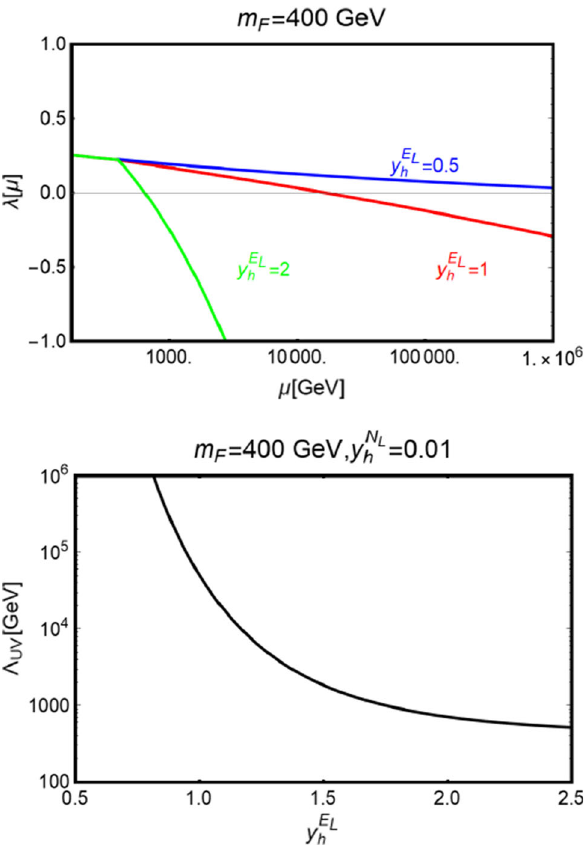
Fig. 3 Top panel evolution of the Higgs quartic coupling λ with the energy scale μ for three assignations, i.e. 0.5, 1 and 2, of the Yukawa coupling y E L . The VLL have been assumed to be at a scale m F = h 400GeV while the neutral Yukawa coupling y N L has been set to 0.01. h , y E R The other two Yukawa couplings y N R have been set to zero in h h order to have a SM-like diphoton rate for the Higgs boson. Bottom panel evolution of the scale (cid:13) UV , defined by λ((cid:13) UV ) = − 0 . 07 with the coupling y E L . The other parameters have been set as in the upper h panel